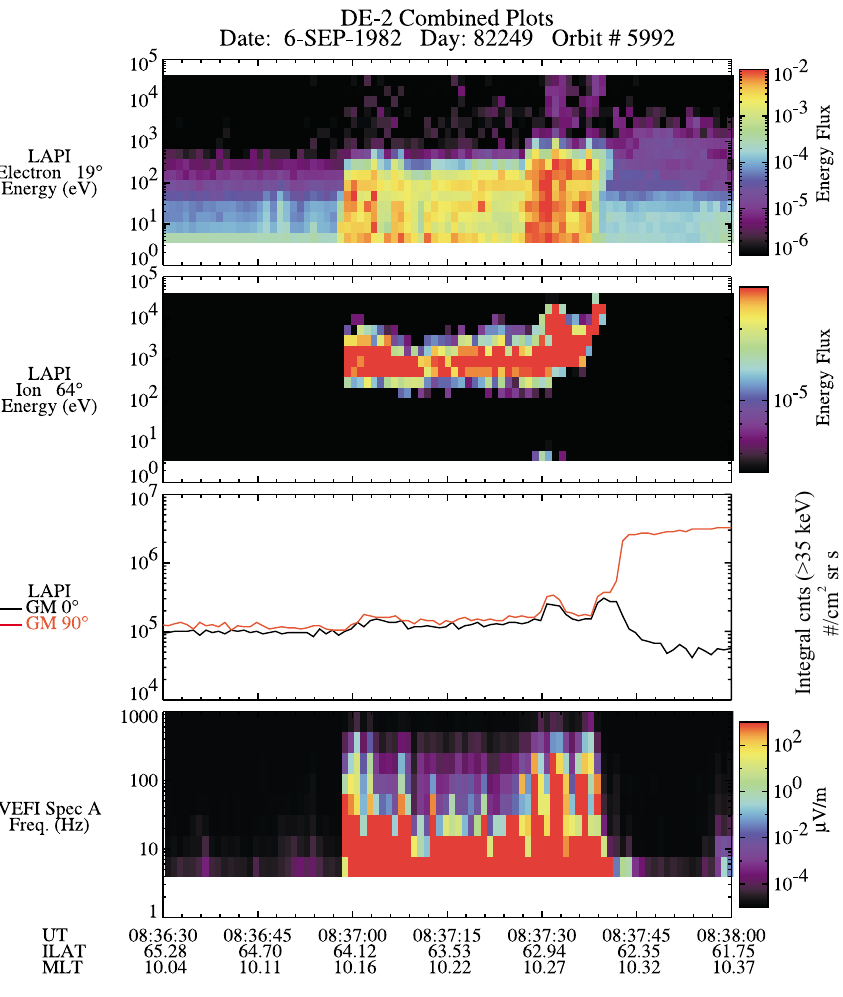
Fig. 1. DE-2 data from 6 September 1982 showing a cusp dispersion signa- ture in the ions with a small V at the equatorward end. Top panel is elec- tron energy flux, second is ion energy flux. The line plots in the third panel are counts of > 35 keV electrons in the parallel (black) and perpendicular (red) directions. The bottom spectrogram is electric field wave power up to 1